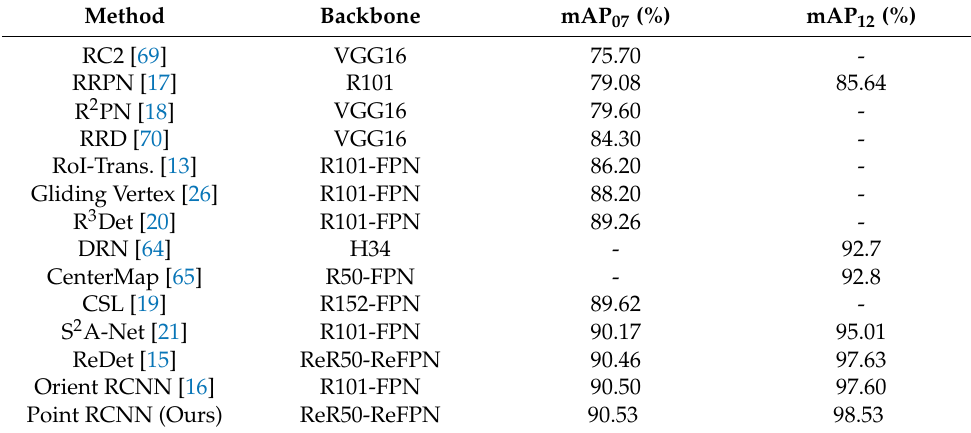
Table 4. Performance comparisons for the HRSC2016 test set. mAP 07 and mAP 12 indicate that the results were evaluated under VOC2007 and VOC2012 metrics (%), respectively. We report both results for fair comparison. “R50” denotes ResNet-50, “R101” denotes ResNet-101, “R152” denotes ResNet-152, “H34” denotes Hourglass-34, “ReR50” denotes ReResNet-50.